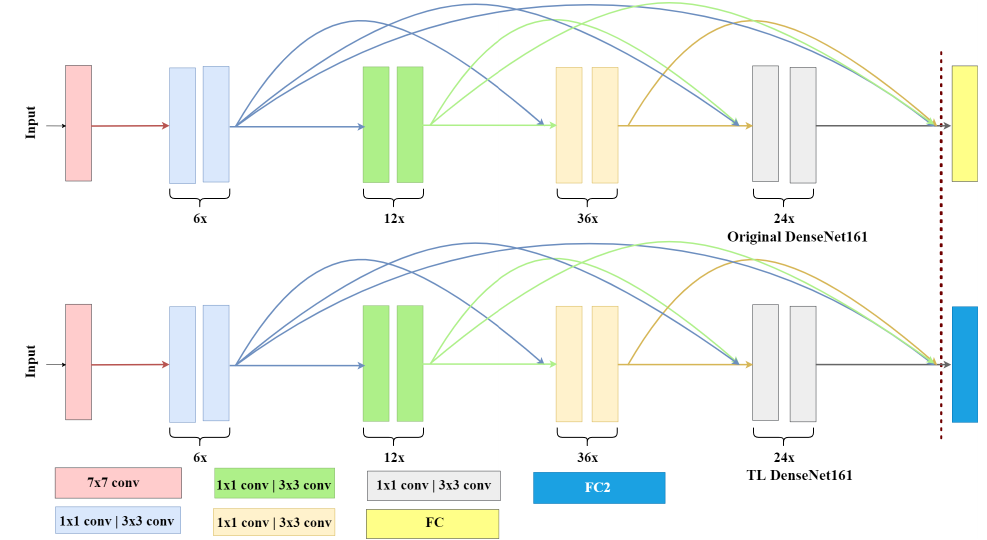
Figure 9. DenseNet161 and TL DenseNet161